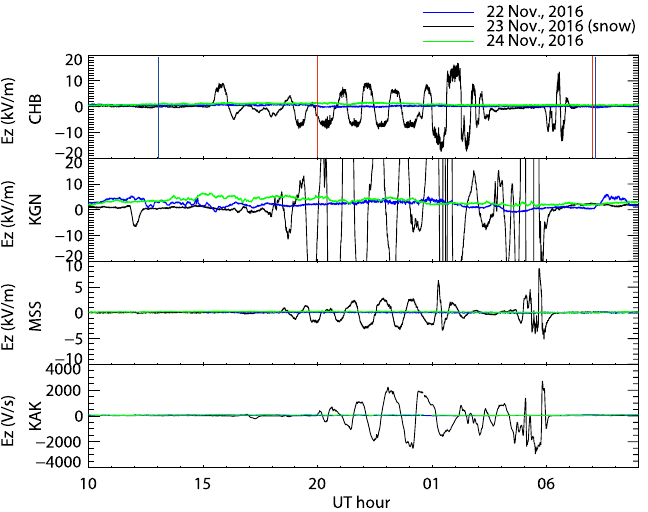
Figure 2. Variation in the atmospheric electric field at CHB, KGN, MSS, and KAK during 23–24 November, 2016. The blue and green lines indicate the atmospheric electric field on the reference days before and after the snow day. On the CHB panel, the vertical blue and red lines indicate the onset of precipitation and time interval of snowfall, respectively, based on weather data from the Japan Meteorological Agency.